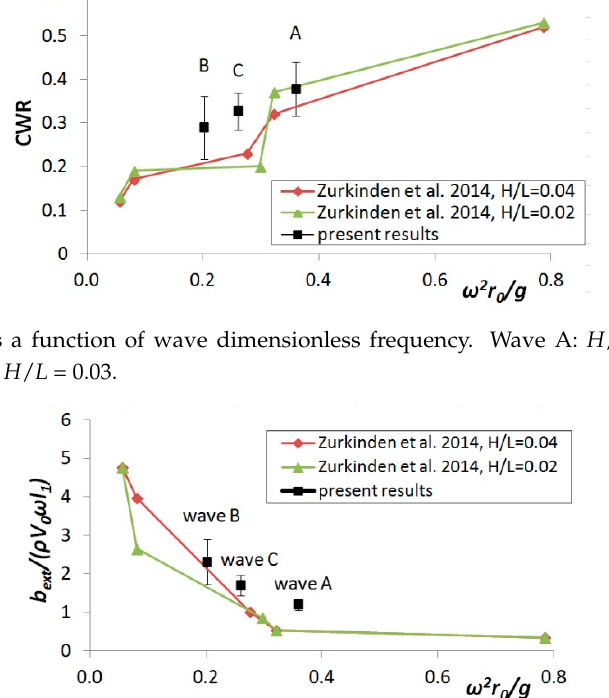
Figure 13. Dimensionless optimal damping for the float-only configuration. Wave A: H / L = 0.03; wave B: H / L = 0.02; wave C: H / L = 0.03.